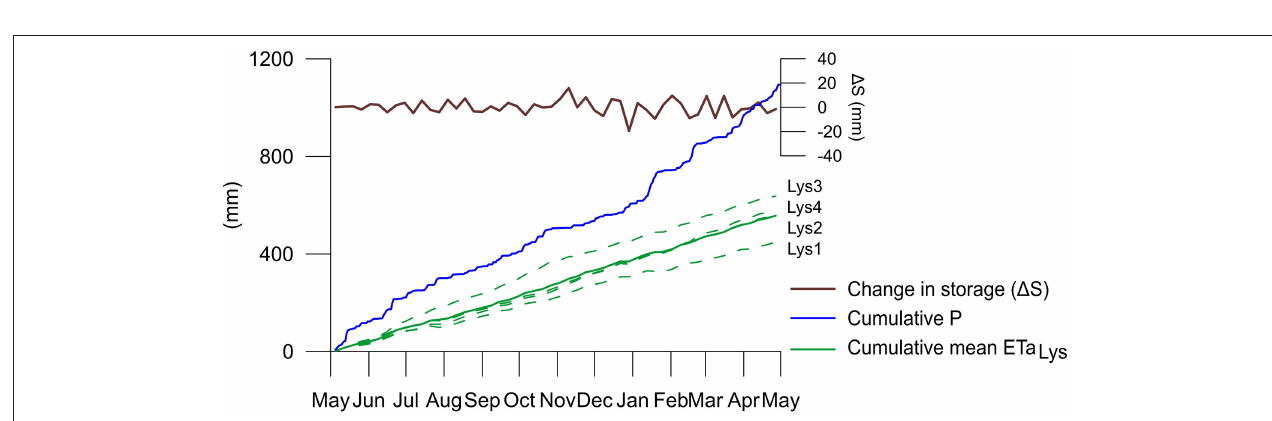
FIGURE 7 | Cumulative evapotranspiration measured with the four lysimeters every 7 days, cumulative precipitation, and the change in soil water storage ( 1 S).